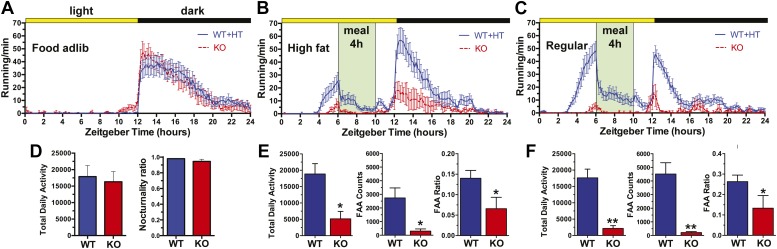
Disc-running activity of D1R KO (n = 4, red curves and bars) and WT/HT mice (n = 12, blue curves and bars) during ad-lib and temporal food restriction schedules.(A) Group mean (±SEM) waveforms of activity in 10 min bins during ad-lib food access. Data from each mouse are averages of the last 7 days prior to restricted feeding (red dashed lines and bars). Lights-on (ZT 0–12) is indicated by the yellow bar. (B) Group mean waveforms of activity during restricted feeding (4 hr daily access to a moderately high fat diet). (C) Group mean waveforms of activity during restricted feeding regular chow. (D) Total daily activity and nocturnality ratios of WT and KO mice during ad-lib food access. (E) Total daily activity, FAA (2-hr pre-meal) counts, and FAA ratios (2-hr pre-meal counts divided by activity during lights-off) during moderately high fat chow schedule. (F) The same metrics as panel E, during regular chow schedule. * denotes significant difference between WT and KO, p < 0.05, 1-tailed. **denotes significant difference, p < 0.001.